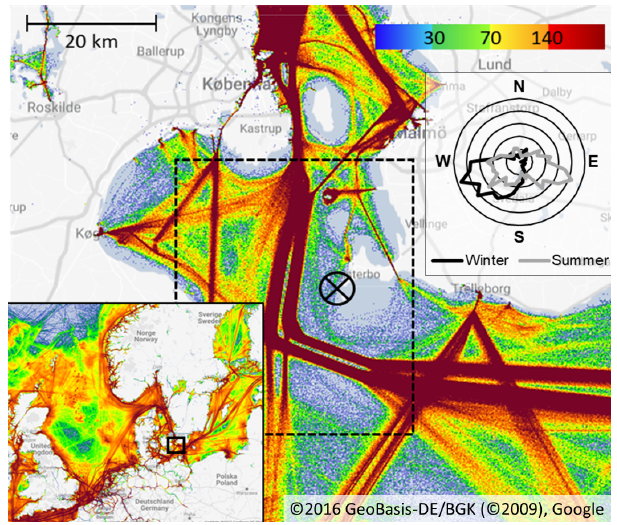
Figure 1. Location of the measurement station (circle with cross) at the Falsterbo peninsula together with ship traffic density; the colour bar indicates an approximate number of distinct vessels passing per day per squared kilometre (https://www.marinetraffic.com/, last ac- cess: 29 March 2016). The dashed square shows the area in which AIS positions are considered for ship identification. Inserted to the right is the wind direction pattern during the winter (black) and sum- mer (grey) campaign respectively.